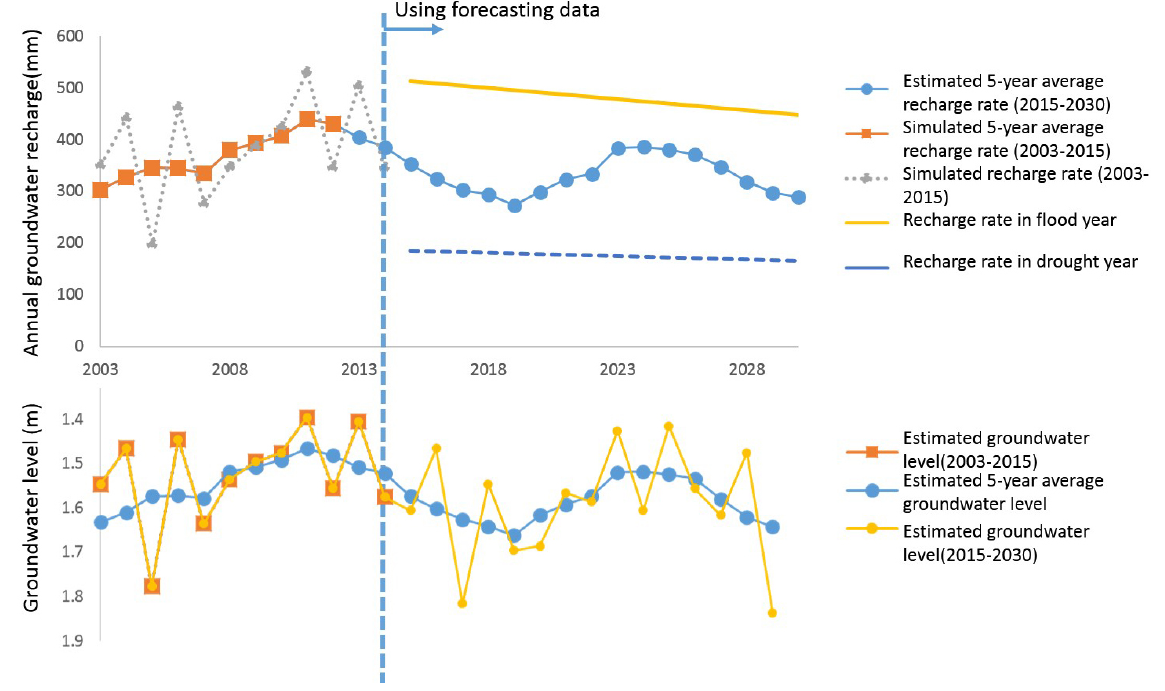
Figure 7. Estimated trend of groundwater recharge rate and groundwater